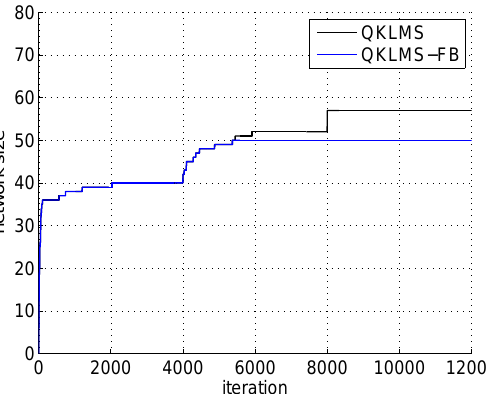
Figure 13. The network size growth curves of the QKLMS and QKLMS-FB algorithms in channel equalization with an abrupt change in